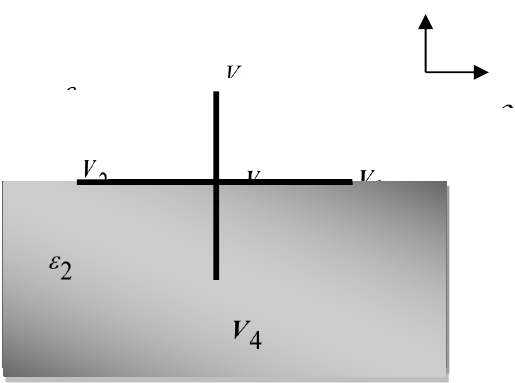
Figure 1. Interface between media of dielectric permittivity and